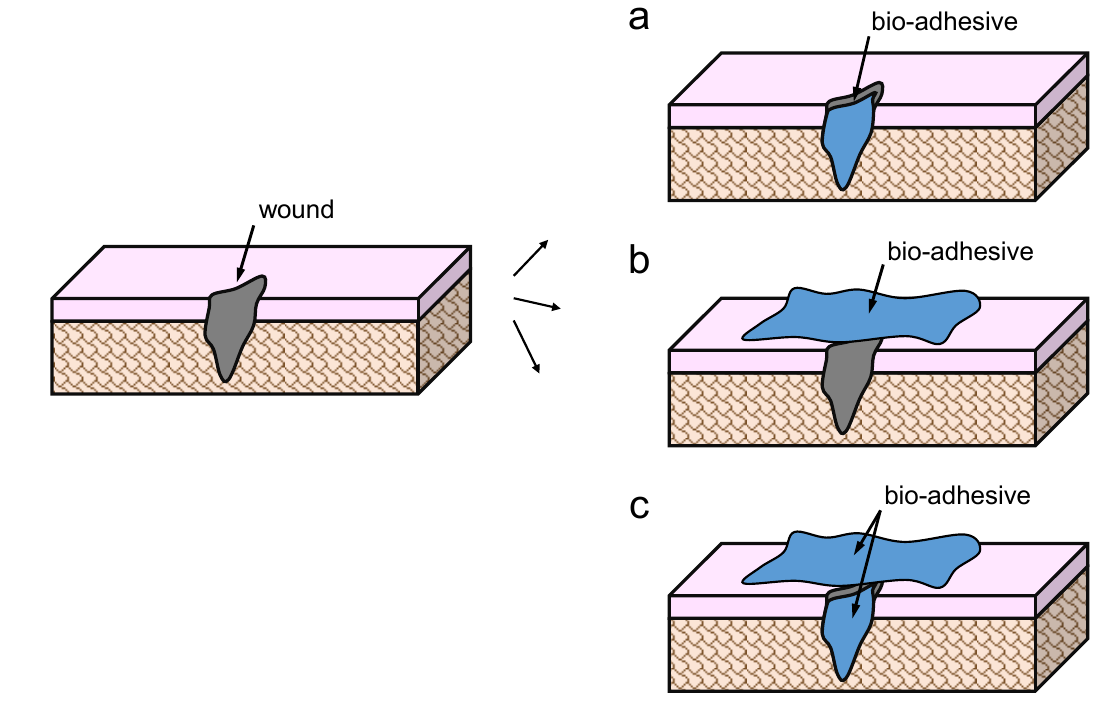
Figure 6. Bio ‐ adhesives used for wound closure by ( a ) joining the tissue beneath the surface, ( b ) joining the two sides of the injury, or ( c ) combining both (adapted from [92]).